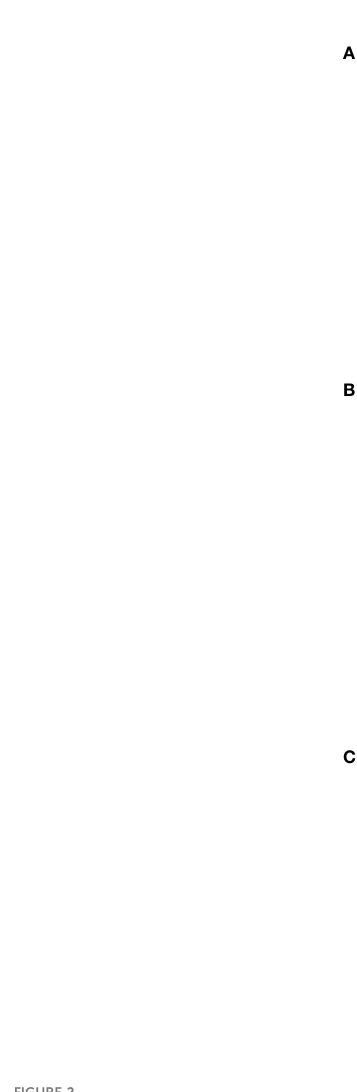
FIGURE 2 Adoptive B cell therapy improves viral control. (A) Summary of viral control in sera. (B) Summary of viral loads in spleen. (C) Summary of viral loads in liver. Experimental layout was similar as the one depicted in Figure 1A. The limit of detection is indicated by a dashed line. Experiments were performed 3 times, n=2-5 mice per experiment. Error bars represent SEM. The p-values were calculated using Mann-Whitney test. * P <0.05, ** P <0.005, *** P <0.0005. Dotted line represents limit of